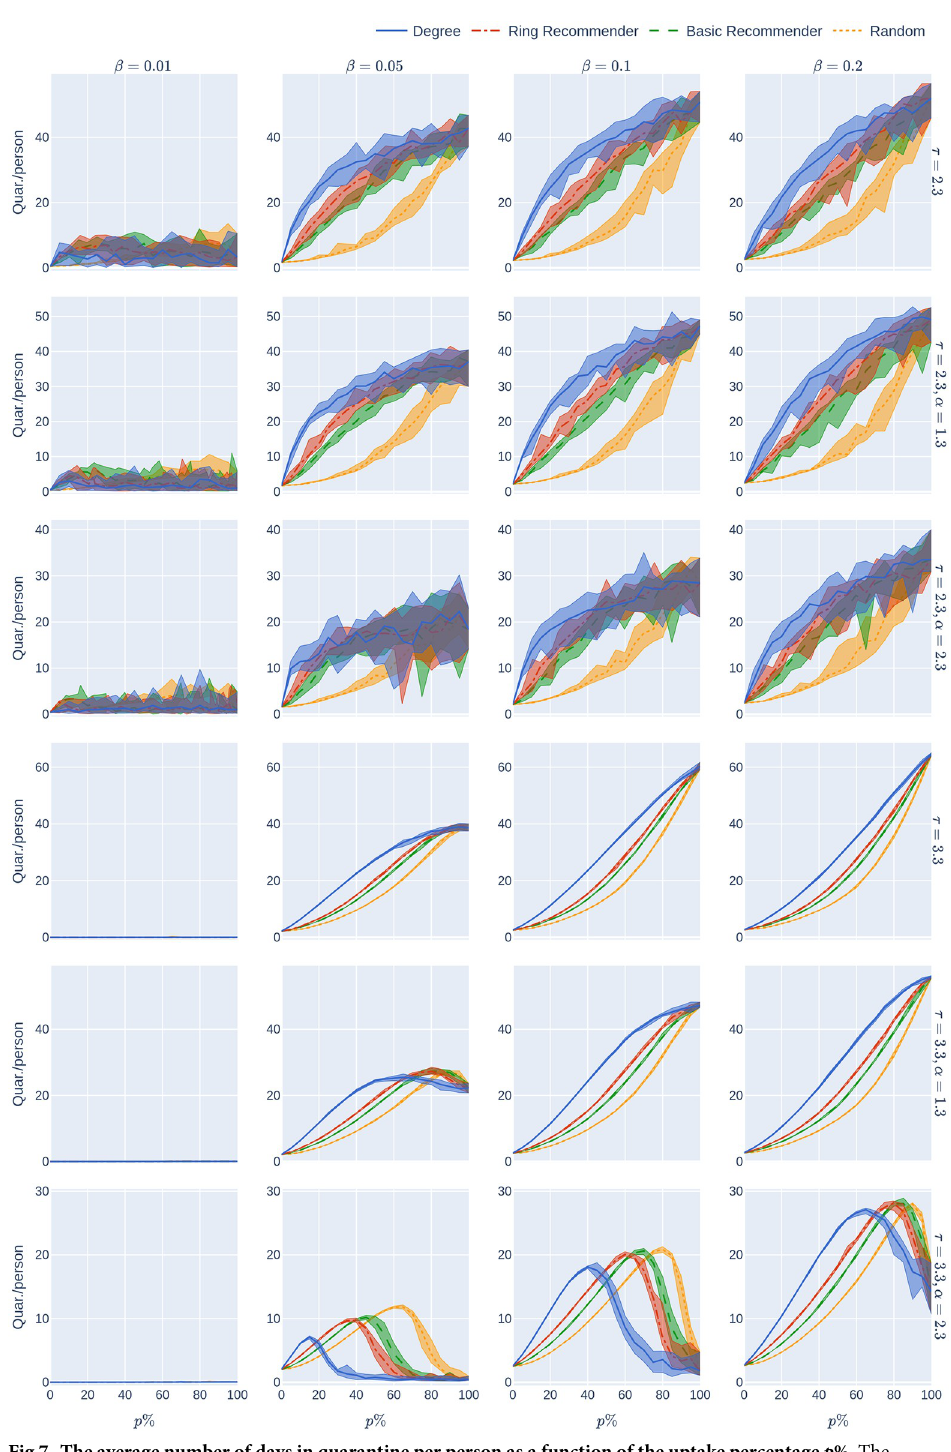
Fig 7. The average number of days in quarantine per person as a function of the uptake percentage p %. The population is modelled using four 500,000-node GIRG networks where τ = 2.3 has more super-spreaders and τ = 3.3 has fewer super-spreaders, α = 1.3 is less geometric and α = 2.3 is more geometric, arranged in the four rows. For comparison, there are two rows for 500,000-node configuration models with τ = 2.3 and τ = 3.3. The x -axis shows the uptake percentage p % varying from 0 to 100% at step size 5%. Simulations are done for the 21 values of p % corresponding to these steps. The y -axis shows the corresponding value Quar ( p ). Different columns indicate varying